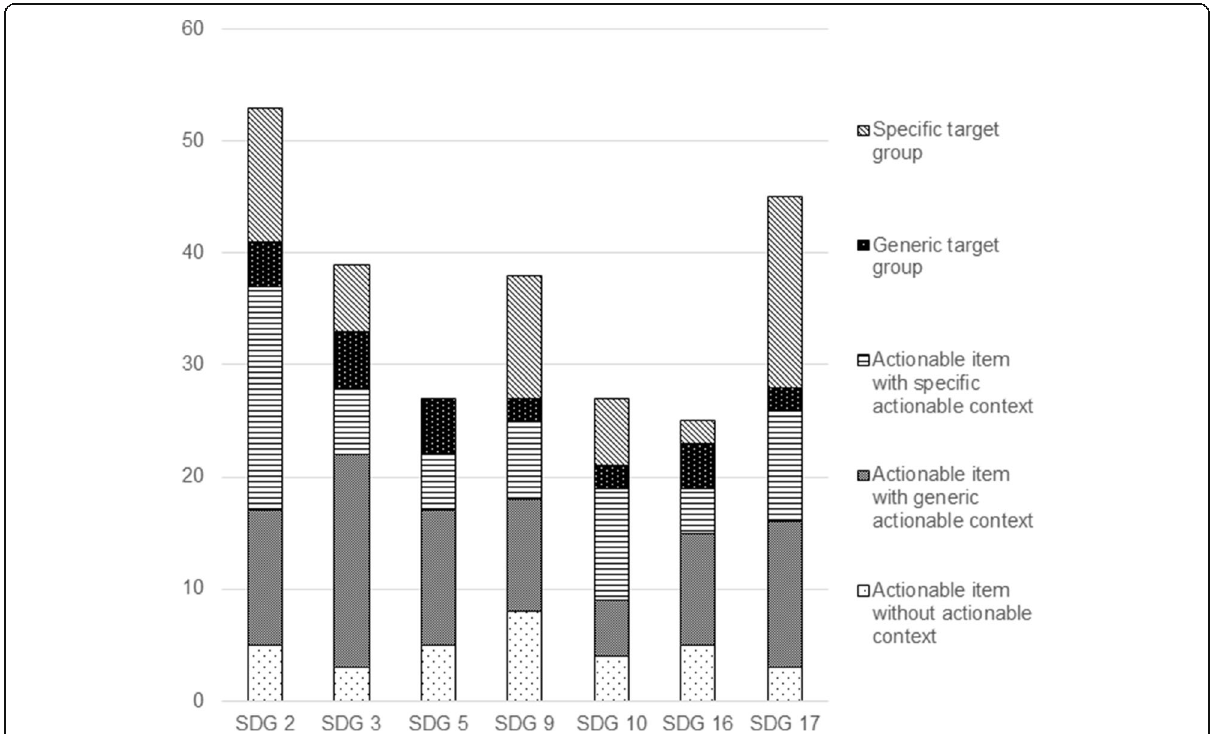
Fig. 10 Actionability and target group specificity by tag. The graph indicates absolute numbers of items, not weighted in terms of individual SDG word count. As there were no instances of non-actionable items, this category is not included in the